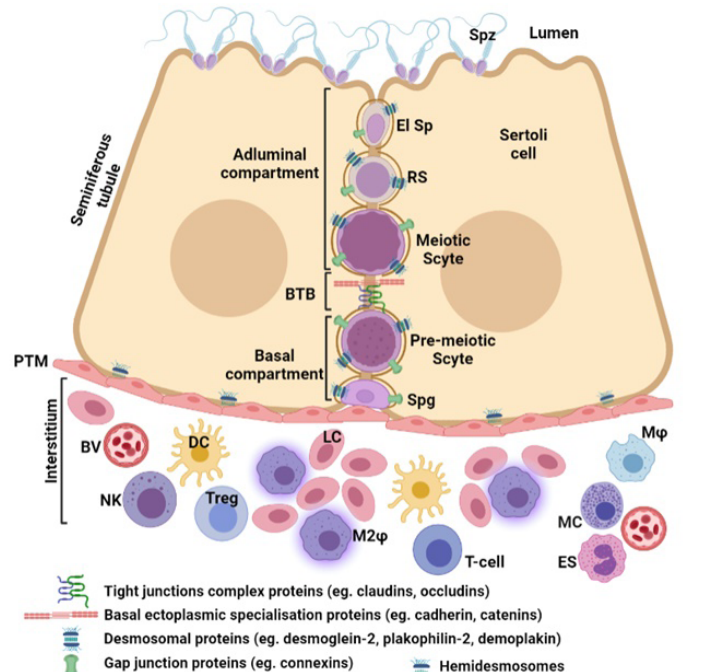
Figure 1. Mechnisms of immune privilege in the testis. Seminiferous tubules comprise of Sertoli cells in close association with germ cells. The BTB divides the seminiferous epitherlium into two compartments: basal compartment, containing the spermatogonia (Spg) and pre-meiotic spermatocytes (Scyte) and adluminal compartment containing metiotic and post meiotic germ cells like round (RS), elongating spermatids (El Sp) and the mature spermatozoa (Spz). The BTB is mainly formed by tight junctions and basal ectoplasmic specialsations. Other cell junctions like desmosomes and gap junctions are also present between the germ cells and Sertoli cells. The peritubular myoid (PTM) cells form the basal membrane of seminiferous tubules. The interstitium contains blood vessels (BV) and is populated by Leydig cells (LC) along with immune cells like macrophages (Mφ), alternately activated M2 macrophages (M2φ), dendritic cells (DC), T- and Treg cells, natural killer (NK) cells, mast cells (MC), and eosinophils